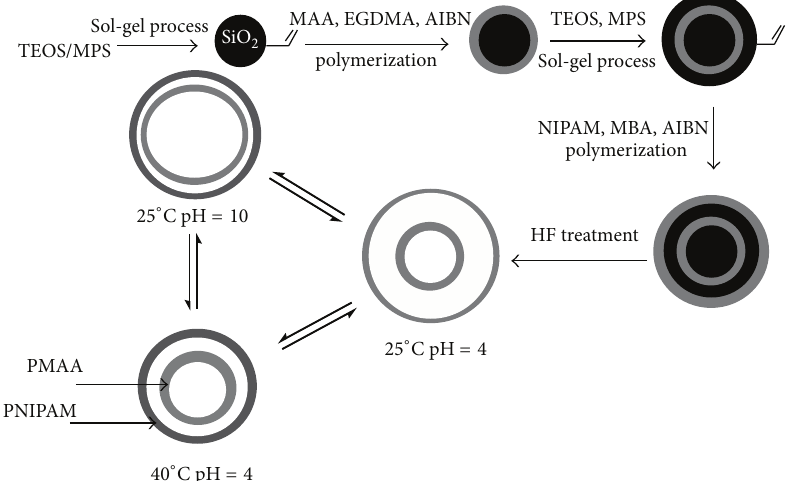
Figure 8: Preparation of polymer/SiO 2 multilayer hybrid microspheres and double-walled concentric hollow polymeric microspheres with independent sensitivity to pH and temperature (reproduced from [101], with permission from American Chemical